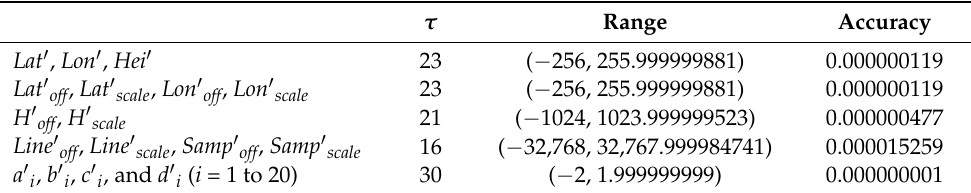
Table 6. Scale factors for parameters of Second